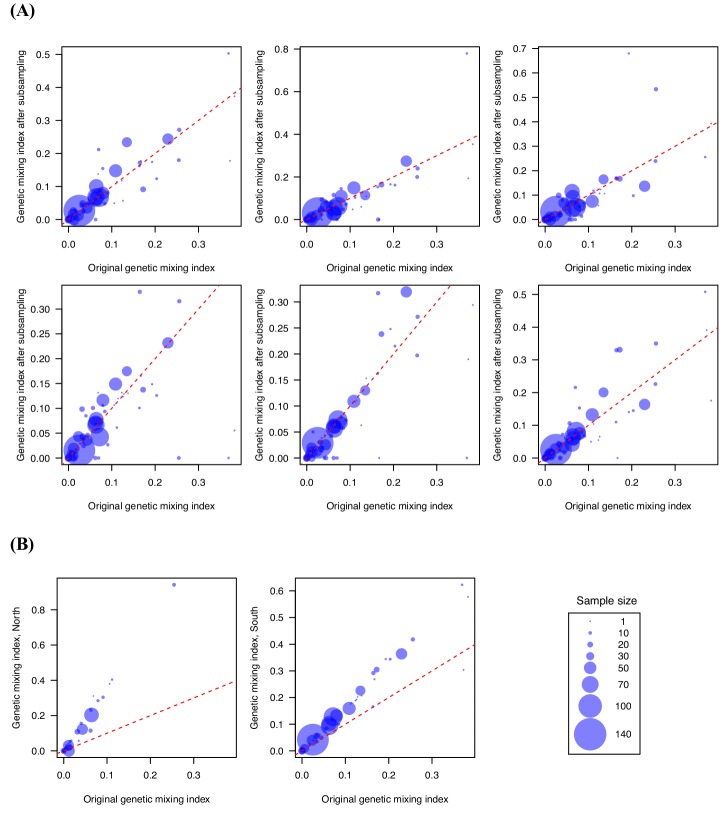
Genetic mixing index was robust to subsampling randomly and geographically.We performed subsampling (80%) (A) and separated the northern and southern samples (B) to test the sensitivity of genetic mixing index to sampling, and the results remained qualitatively similar. (A) shows six independent replicates of subsampling. The latitude of 22.6 was used as the cutoff for separating the northern and southern samples. These results suggest that the importation index is a robust measure.